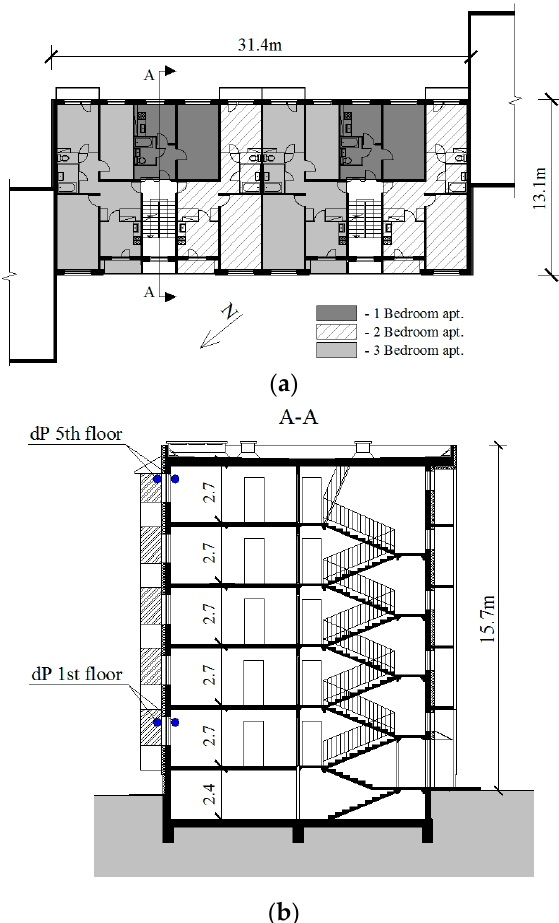
Figure 3. ( a ) Floor plan and ( b ) cross-section with pressure difference measurement point locations of the studied building.